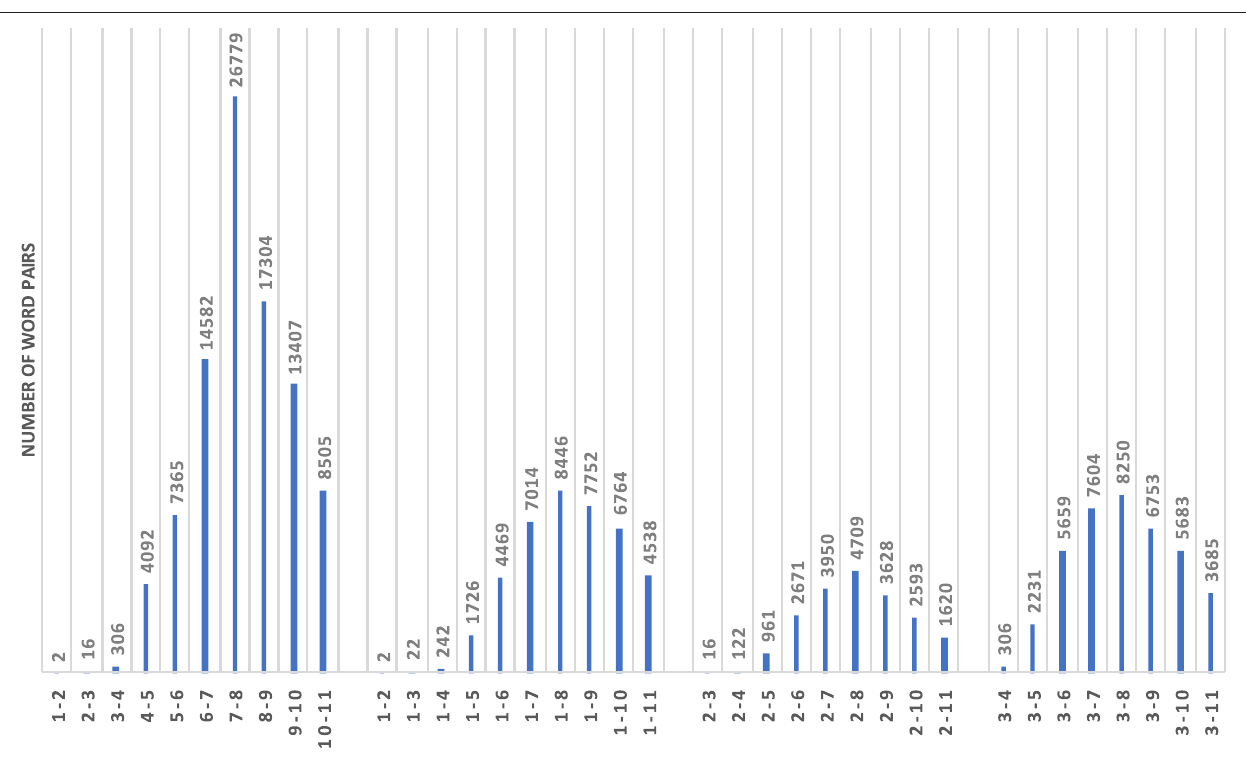
FIGURE 4 | Numbers of word pairs in synset combinations across hierarchical